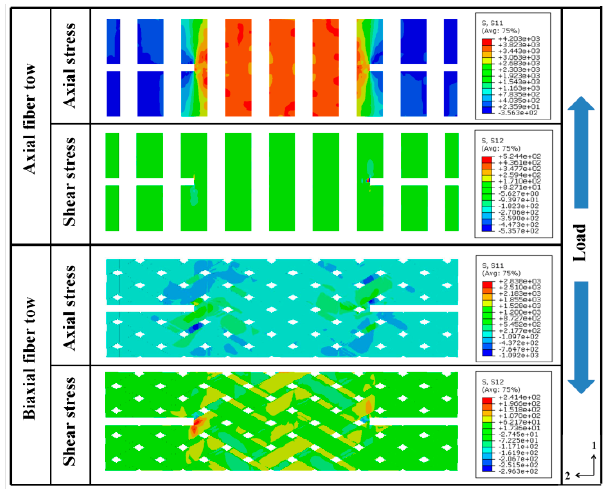
Figure 7. Numerical predicted stress contours before the instant of failure under axial tension.